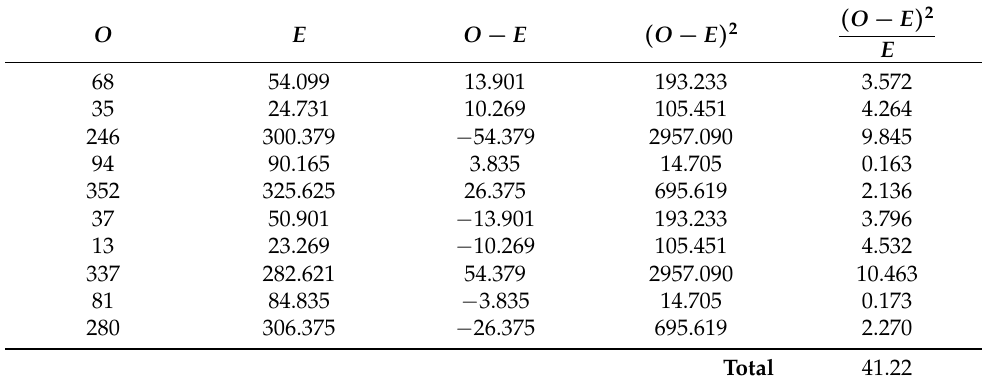
Table 6. Chi-square calculus for the question “Where did you acquire Apple and Samsung products?”. O: Observed. E: